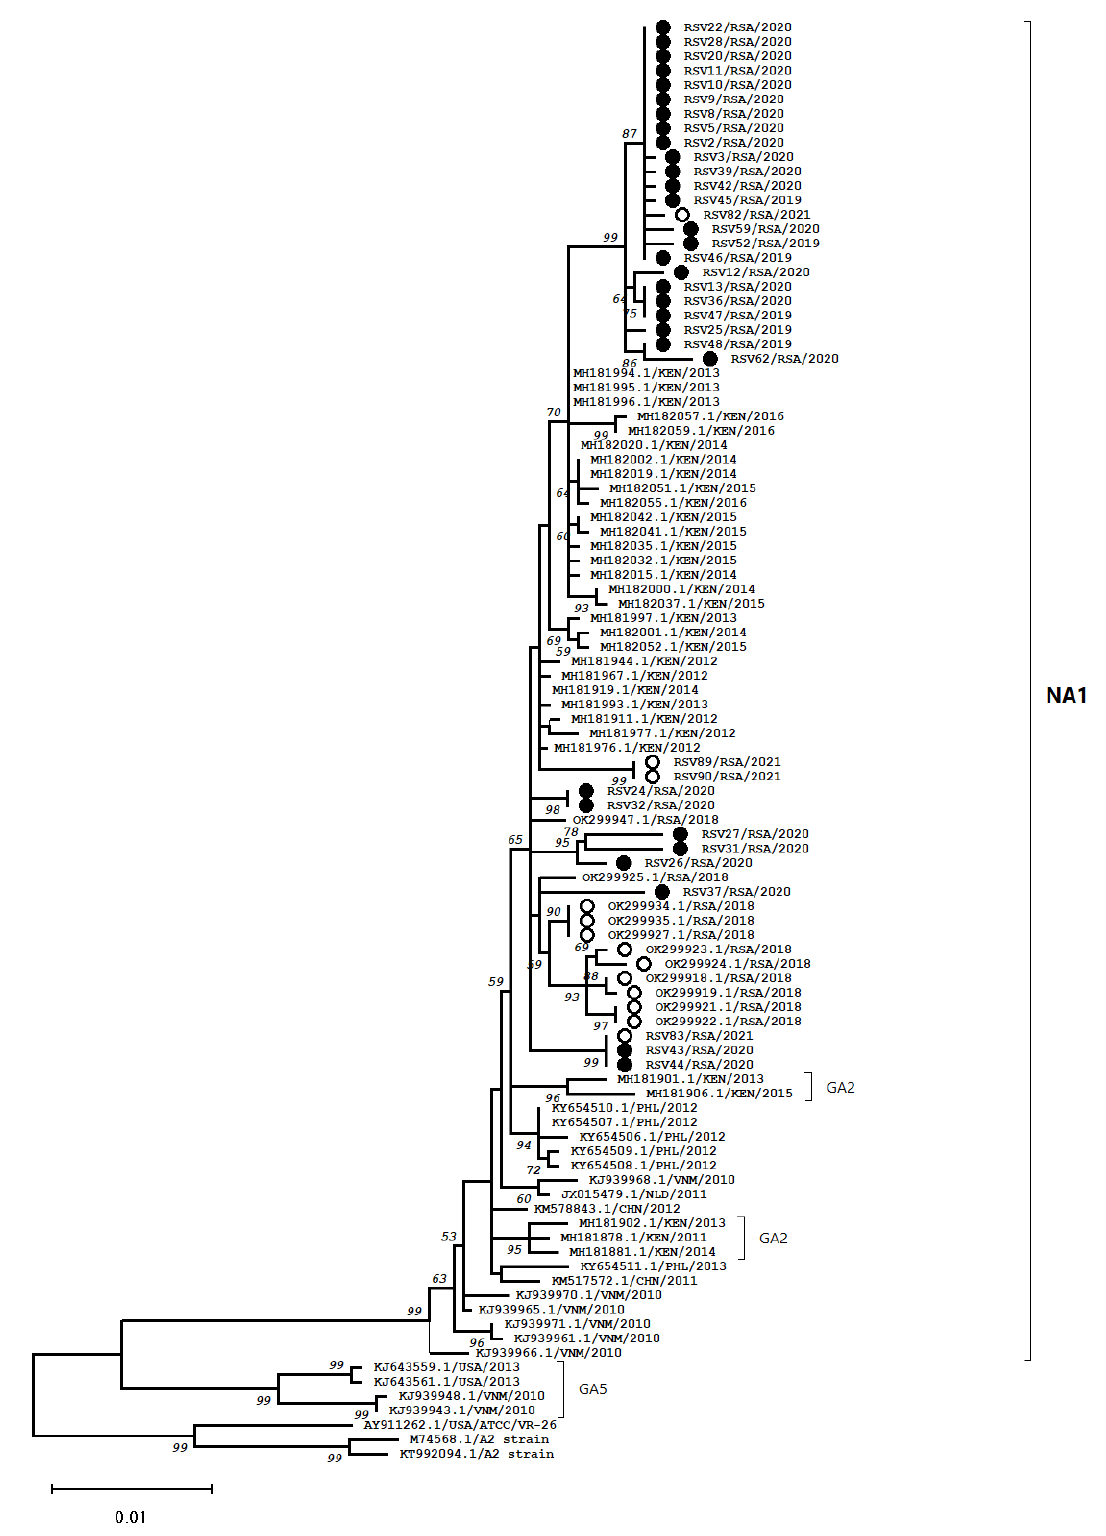
Figure 1. Maximum-likelihood phylogenetic tree based on the 1716 bp long F gene sequences of RSV-A strains from South Africa that circulated in 2019 and 2020 (filled black circles). Reference South African strains are indicated by open black circles. A2 Long strains were used as root. Genotype classification used are based on G protein gene sequence genotypes assigned to reference sequences .